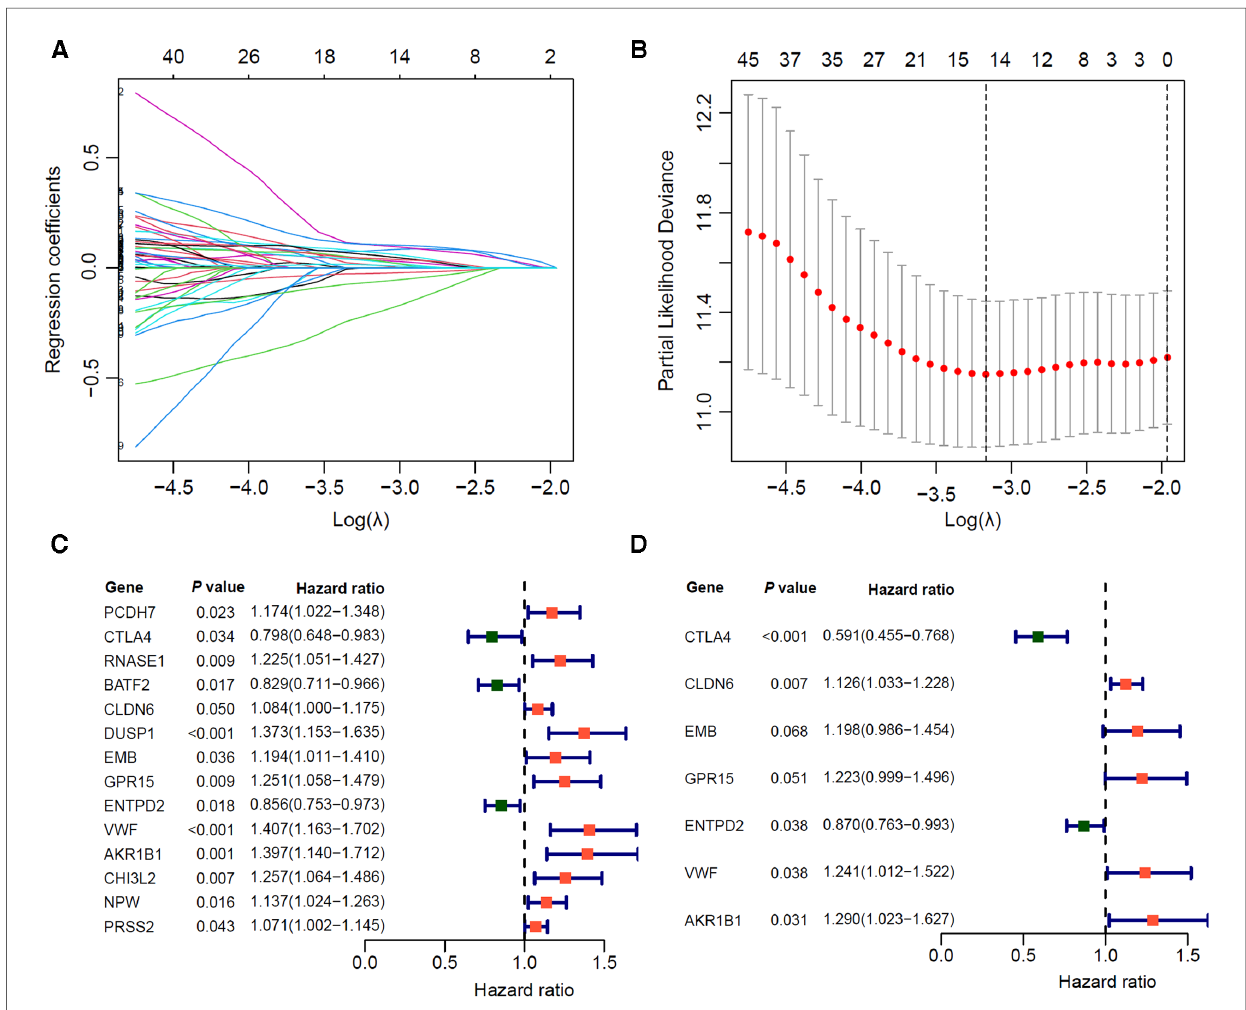
FIGURE 4 Screening of prognostic related hub genes for gastric cancer in TCGA training cohort. ( A,B ) As the penalty coef fi cient λ increases, the distribution diagram ( A ) and 10-fold cross-validation graph ( B ) of the Lasso-Cox regression coef fi cient of each variable. ( C ) Forest plot of Univariate COX analysis of 14 lasso genes. ( D ) Multivariate COX analysis forest plot of 7 core prognostic